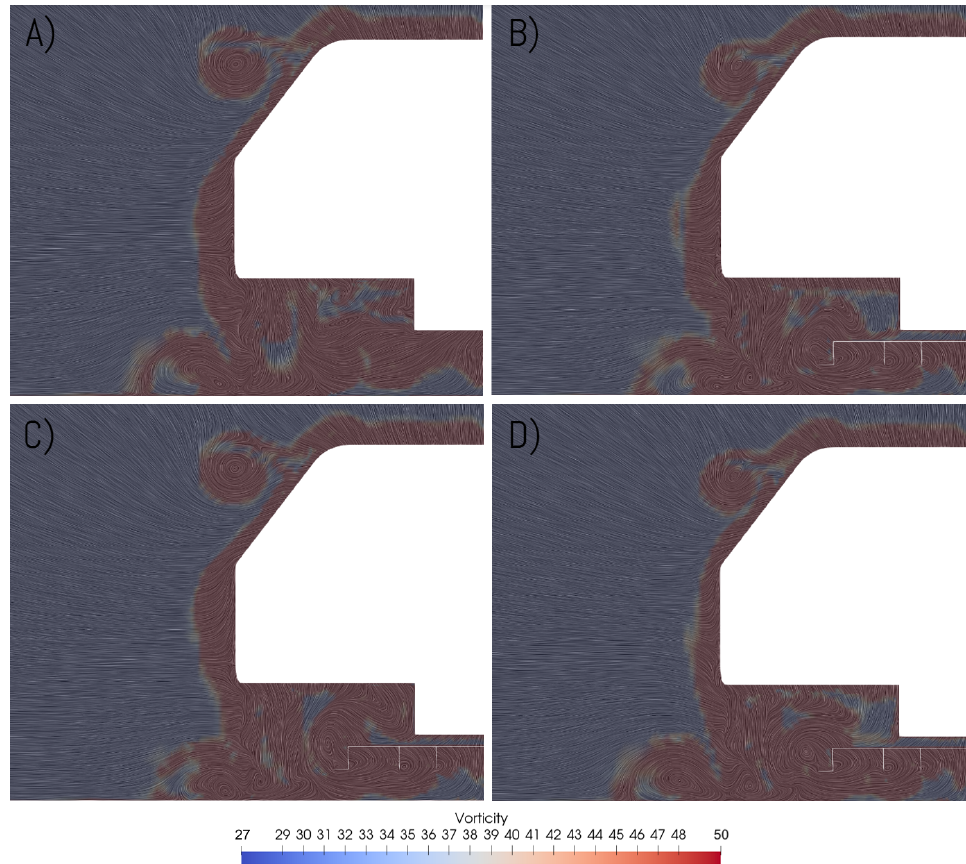
Figure 22. Vorticity map on the XZ-plane of ( A ) baseline, ( B ) Venturi diffuser, ( C ) Venturi skirts, and ( D ) Venturi frontal configurations. Units are s − 1